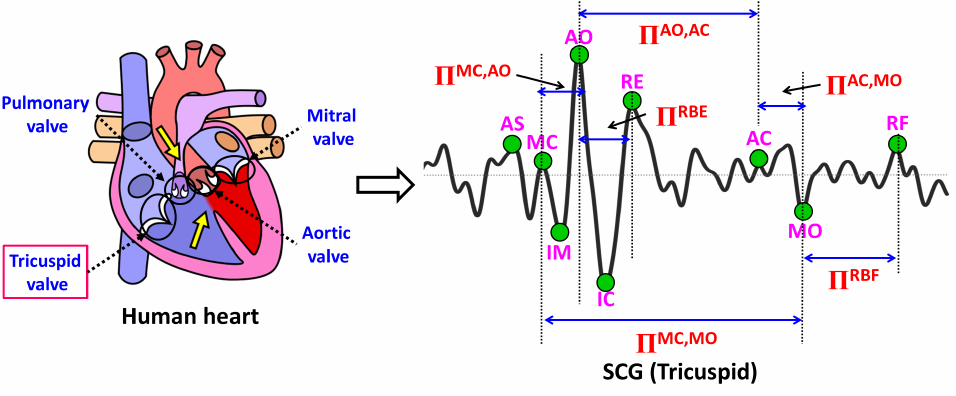
Figure 8. Feature-variables derived from SCG Tricuspid valve